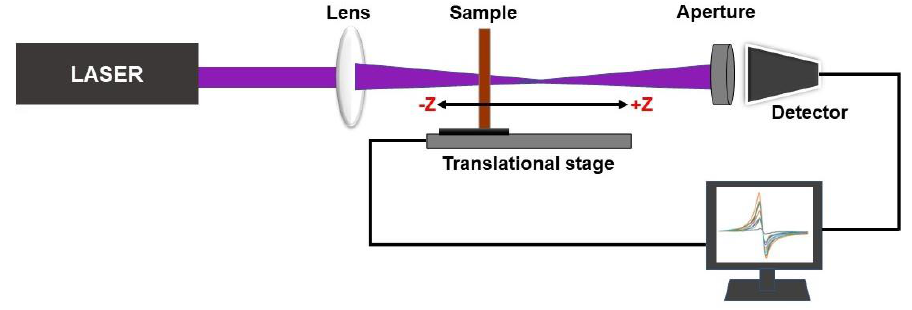
Figure 3. Schematic of the closed aperture Z-scan setup.